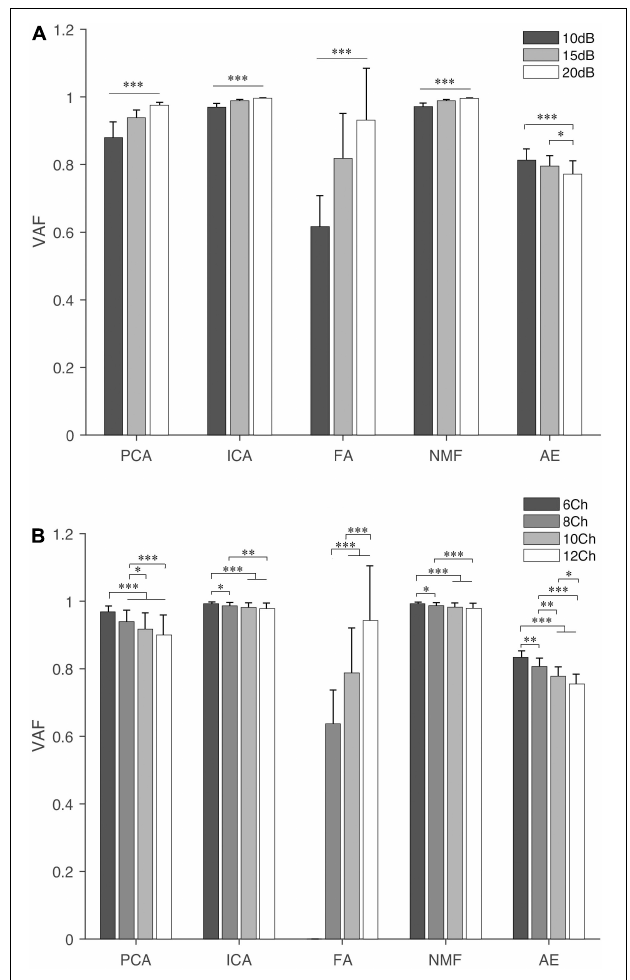
FIGURE 3 | The variance accounted for (VAF) of the five extraction methods under different settings: SNR (A) and NoC (B) . For FA, when four synergies are extracted, at least eight muscles should be included. Thus, three bars are shown for FA. “ ∗ ”, “ ∗∗ ”, and “ ∗∗∗ ” indicate the significance levels are 0.05, 0.01, and 0.001,